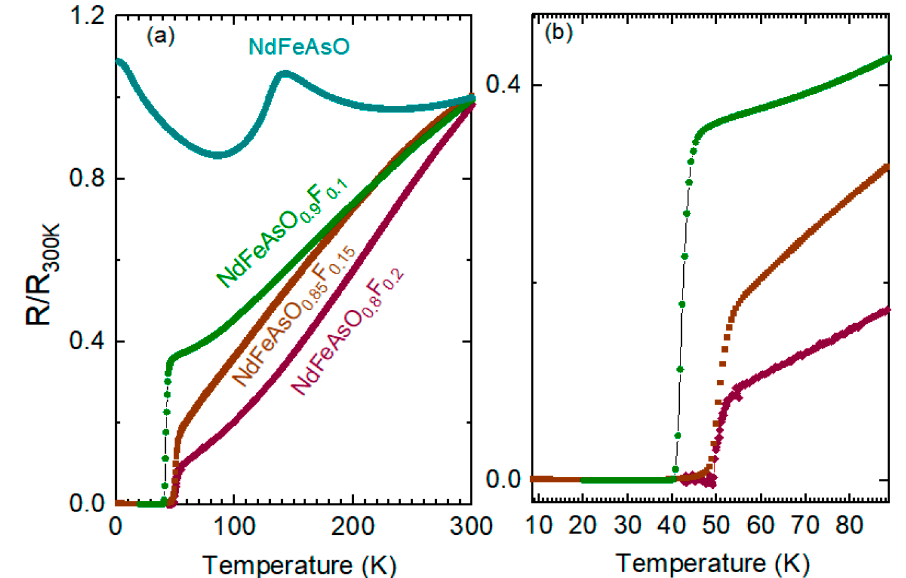
Figure 3. The transport measurements: ( a ) Illustrates the temperature dependence of the in-plane resistance measurements upon the heating of the NdFeAsO 1 − x F x single crystals at x = 0, 0.1, 0.15, and 0.2. ( b ) The close-up of the low-temperature region, highlighting the superconducting